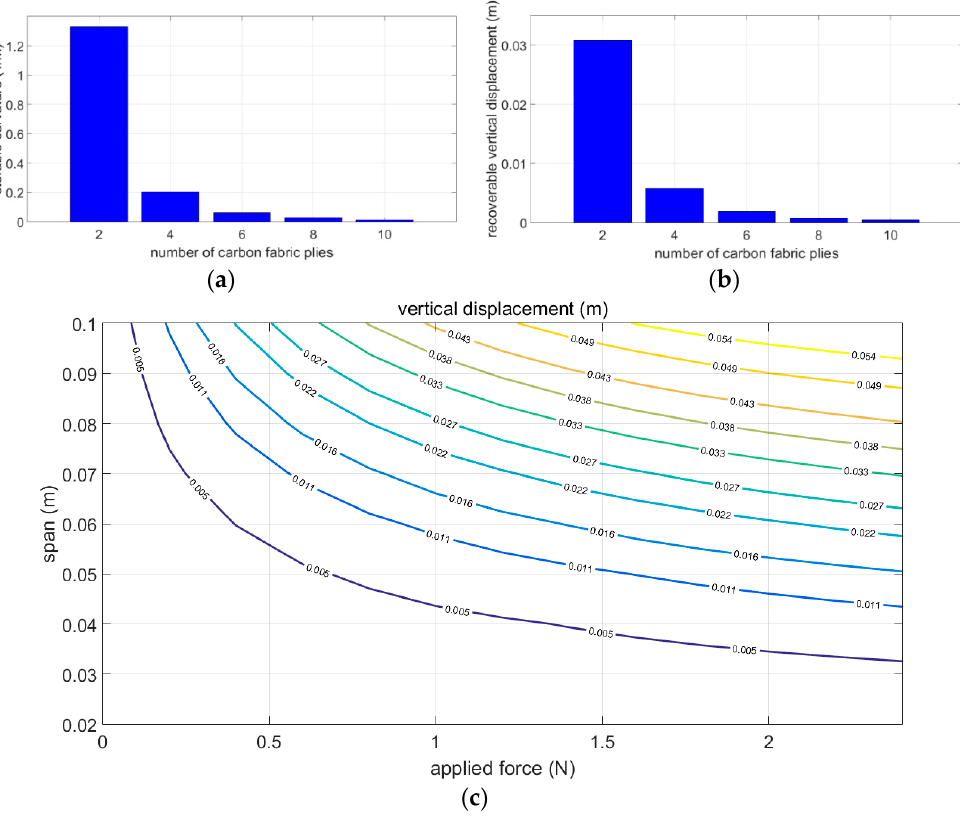
Figure 8. Storable curvature ( a ) and recoverable transversal displacement ( b ) vs. number of carbon fabric plies (against a single SMP internal layer); effect of the span, and of the applied force ( c ) on the transversal displacement for the basic stack configuration (i.e., two external carbon fabric plies and one SMP layer in the middle).